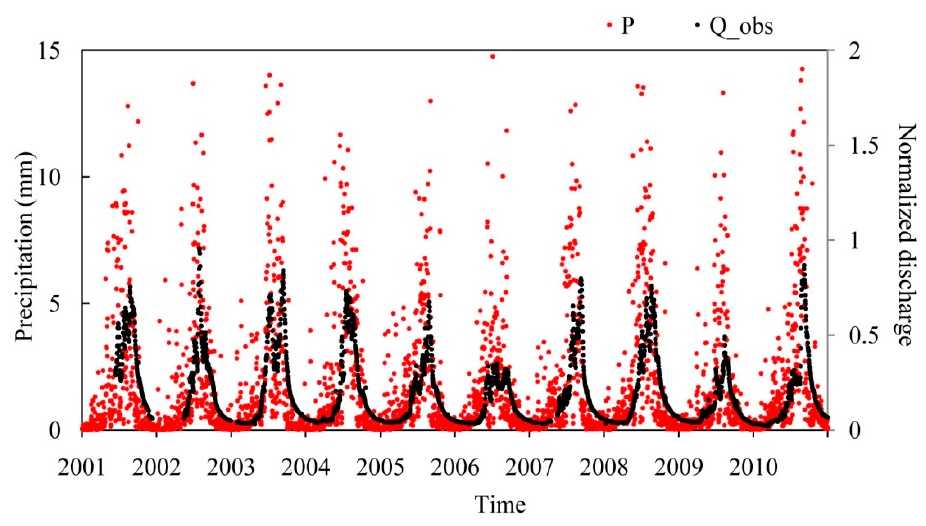
Figure 2. Basin-averaged precipitation ( P ) and normalized observed discharge ( Q_obs ) at the area upstream of Nuxia hydrological station (hereafter the Nuxia basin). Note that the discharge observations used in this study have been normalized using Equation (8) to comply with the policy of the data provider. The precipitation data are from the Tropical Rainfall Measuring Mission (TRMM) dataset.